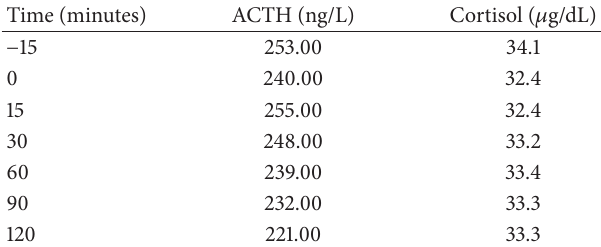
Table 4: CRH stimulation